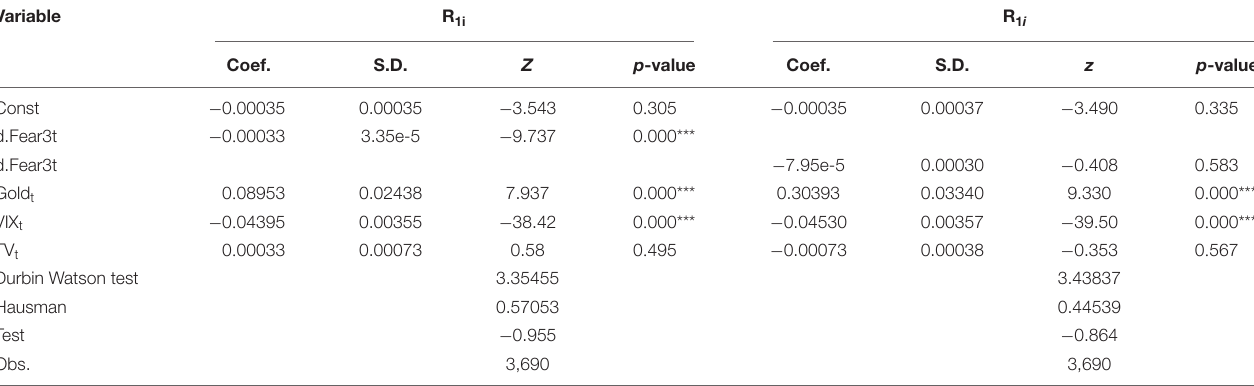
***indicate the significance at 3, 5, and 30% levels, respectively.